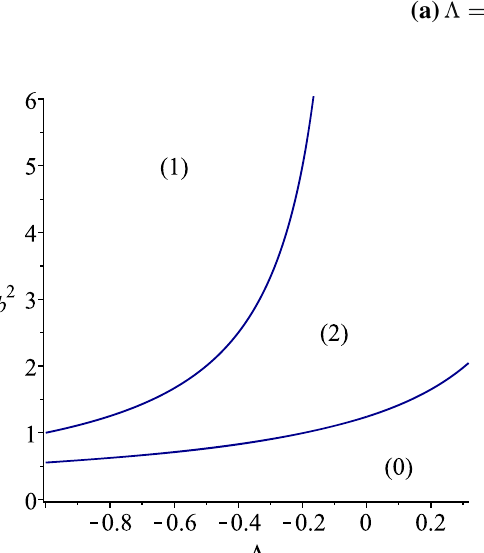
Fig. 7 The regions of different geodesic motions for massive particles in the uncharged BTZ black hole in massive gravity with m 0 = 2 and m (cid:5) = 2 . 54 for